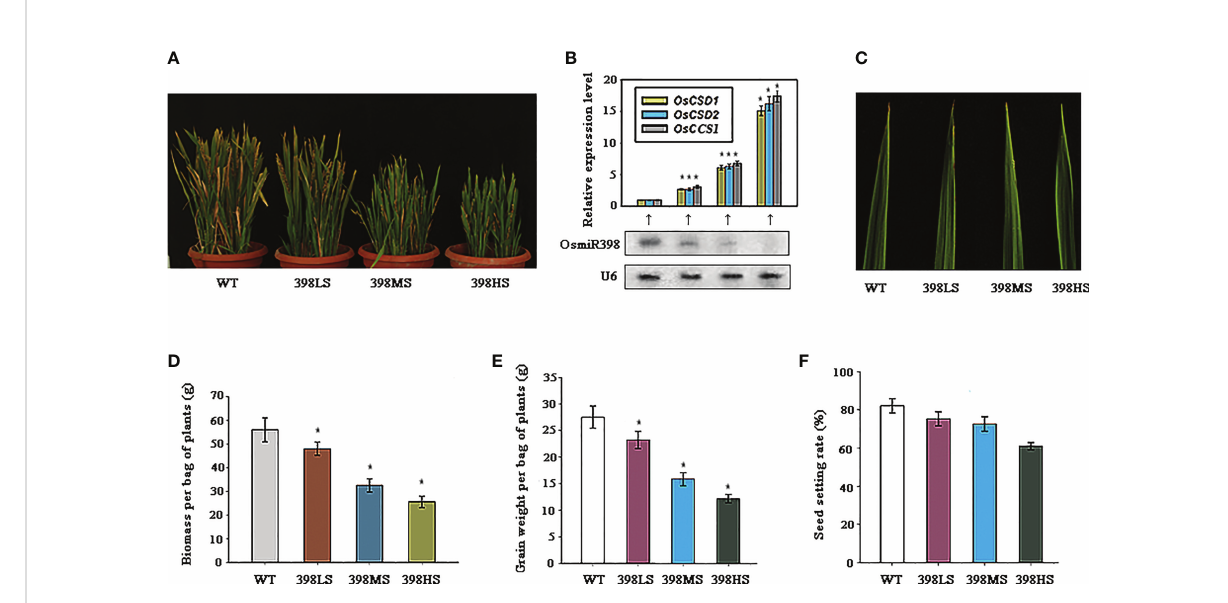
FIGURE 3 The growth traits of miR398 STTM (short tandem target mimic) lines under normal conditions. (A) . Gross morphologies of the WT, 398LS (miR398 low level of STTM), 398MS (miR398 moderate level of STTM), and 398HS (miR398 high level of STTM) at the mature stage. (B) . Expression levels of miR398 and its three targets in the WT, 398LS, 398MS, and 398HS lines. Targets were measured by quantitative Reverse Transcription-PCR (qRT-PCR) and miR398 was detected by northern blot. U6 served as loading control. (C) . Phenotypes of the upmost leaves of the WT, 398LS, 398MS, and 398HS at the elongating stage (90d-old). (D) . Biomass (dry weight) per bag of plant of the WT, 398LS, 398MS, and 398HS at the mature stage. (E) . Grain weight per bag of plants of the WT, 398LS, 398MS, and 398HS after harvest. (F) . Seed setting rates of the WT, 398LO, 398MO, and 398HO at the mature stage. Asterisks indicate signi fi cant difference at P ≤ 0.05 compared with the wild-type by Student ’ s t test (n = 3; means ±